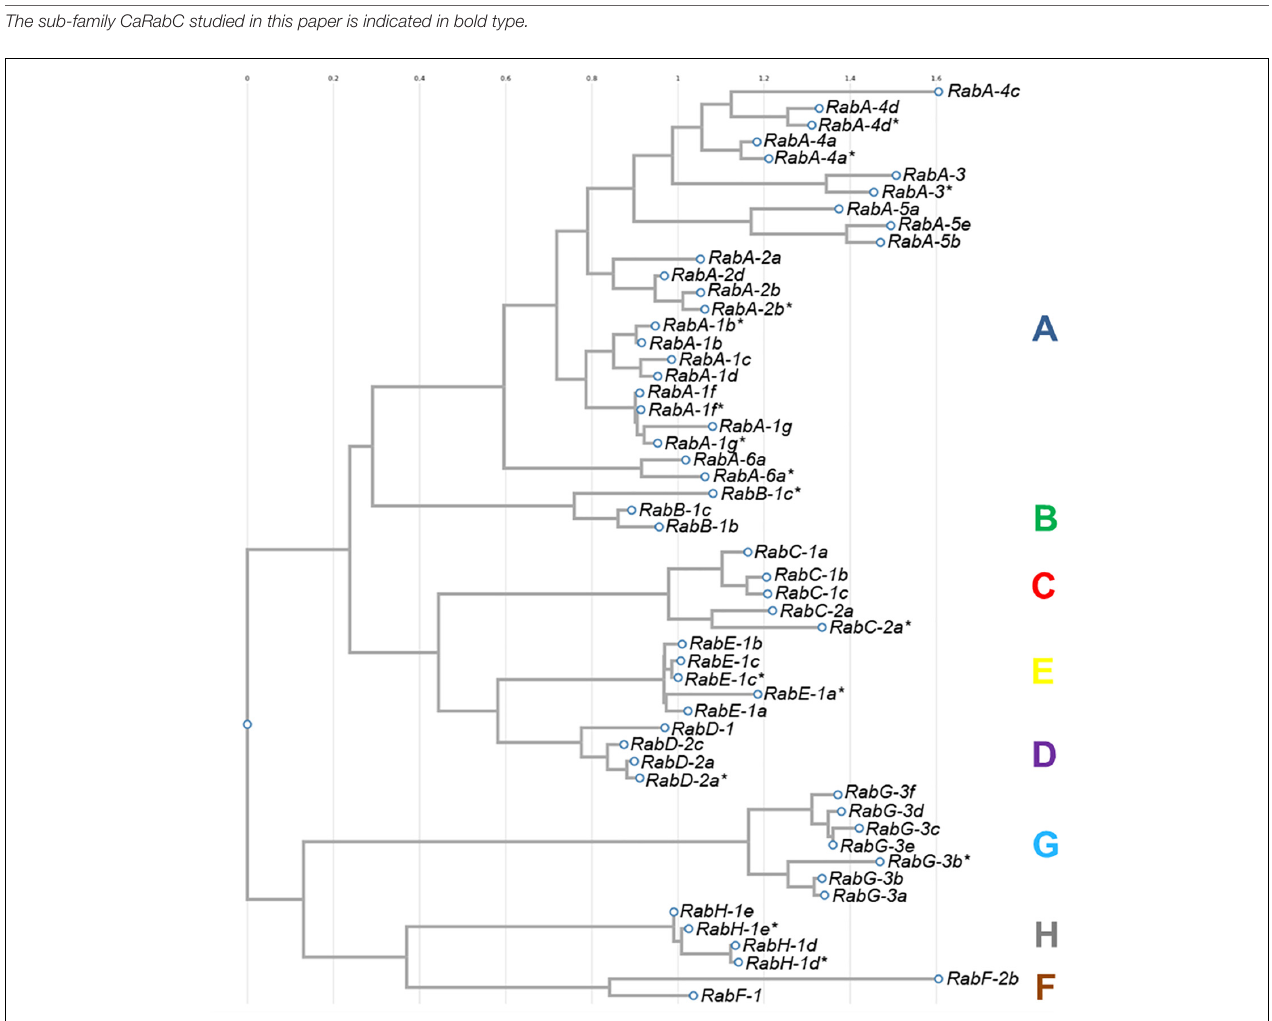
FIGURE 1 | Phylogenetic tree of 54 CaRab gene isoforms identified in chickpea using the FastTree v2.1.8 program. Clades are designated by colored letters identical to the sub-family CaRab gene name.